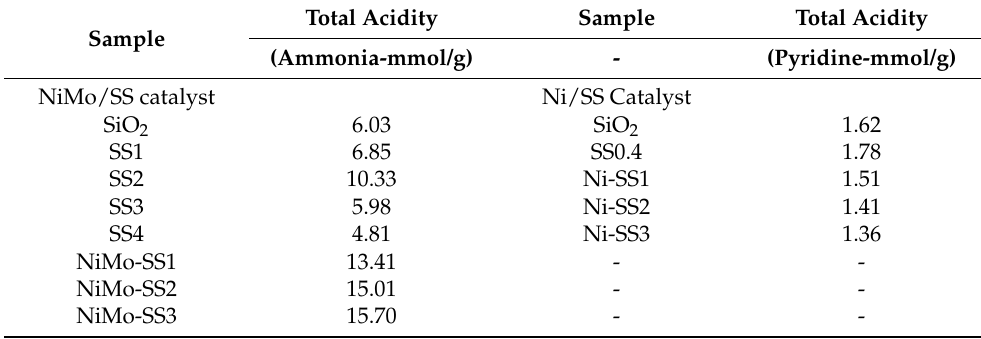
Table 1. Total acidity of the catalysts using